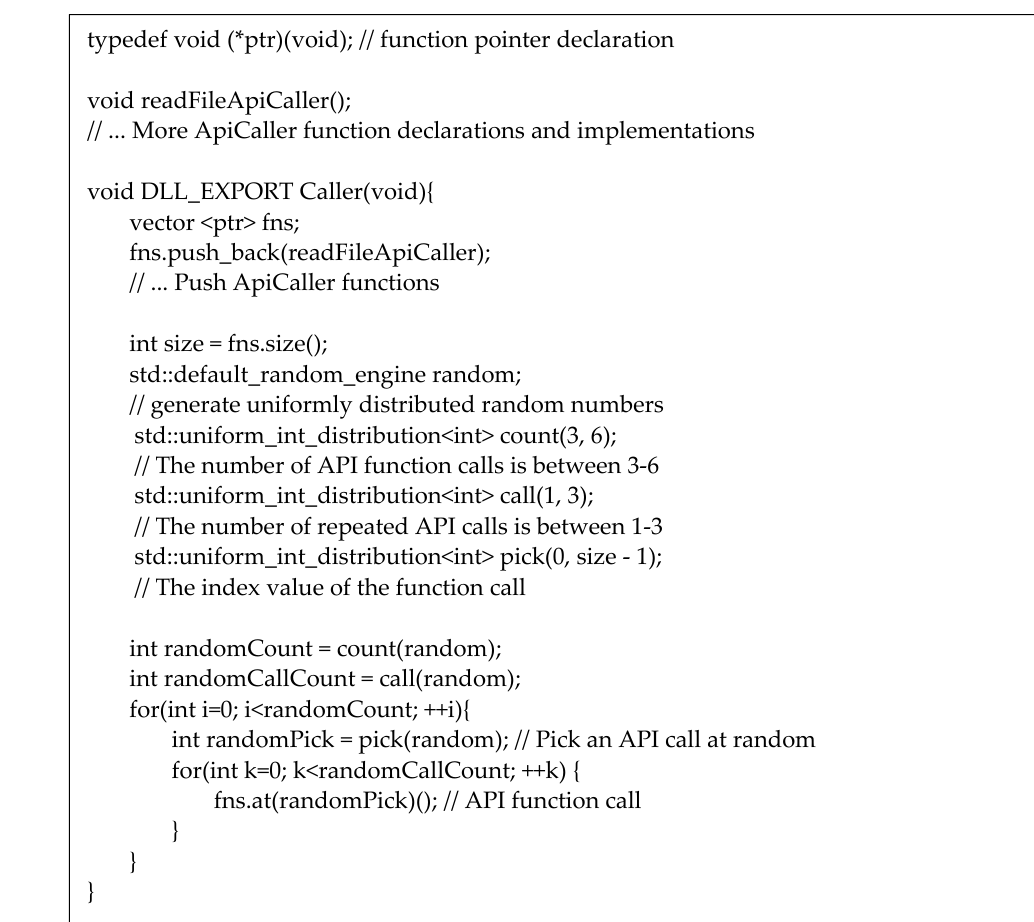
Figure 4. The logic of the hook function.